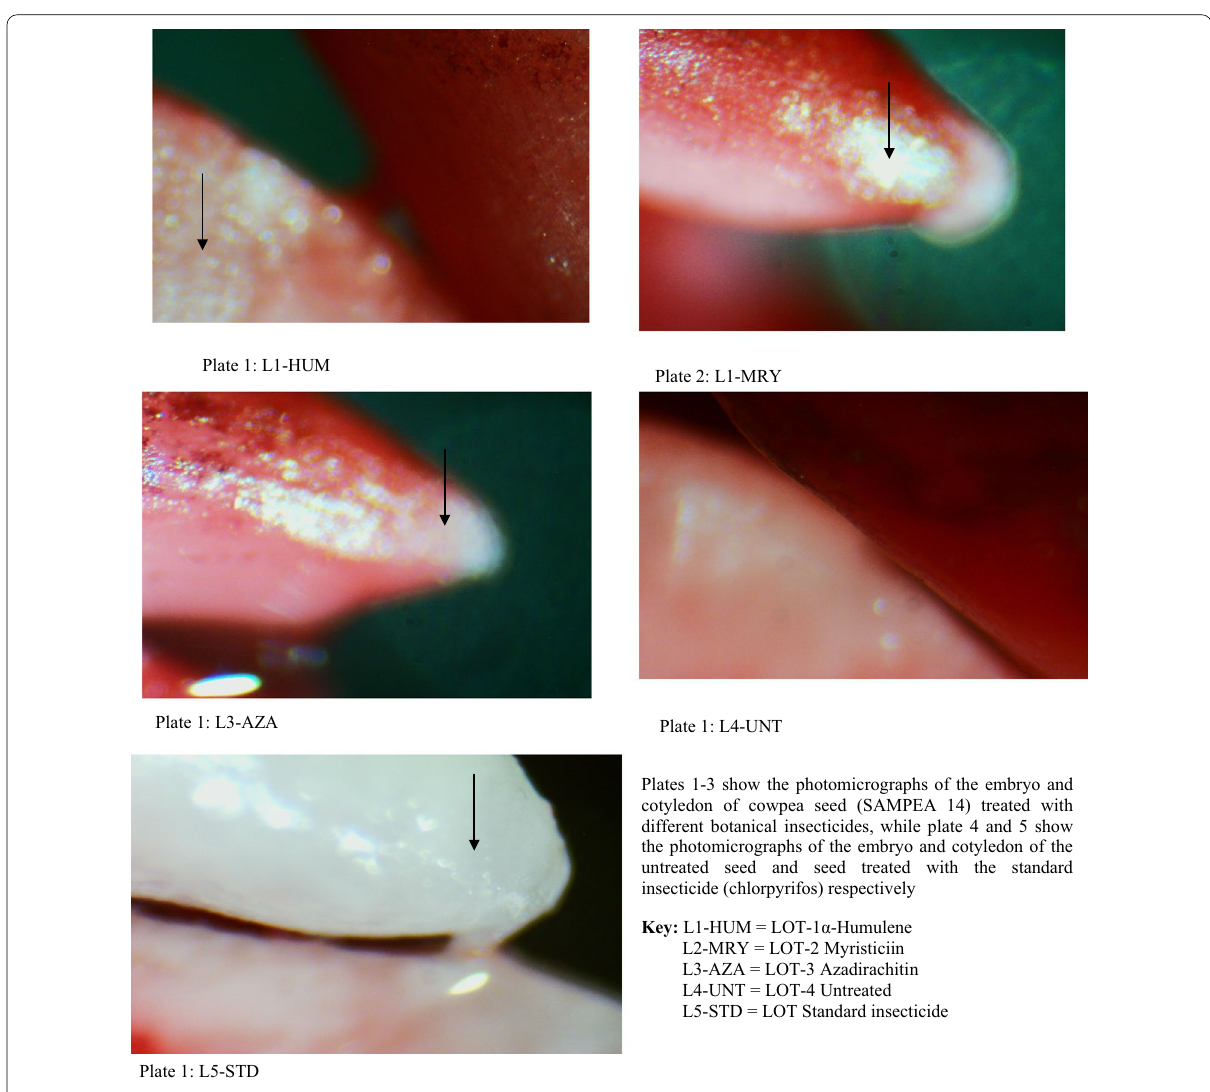
Plates 1-3 show the photomicrographs of the embryo and cotyledon of cowpea seed (SAMPEA 14) treated with different botanical insecticides, while plate 4 and 5 show the photomicrographs of the embryo and cotyledon of the untreated seed and seed treated with the standard insecticide (chlorpyrifos) respectively Key: L1-HUM = LOT-1α-Humulene L2-MRY = LOT-2